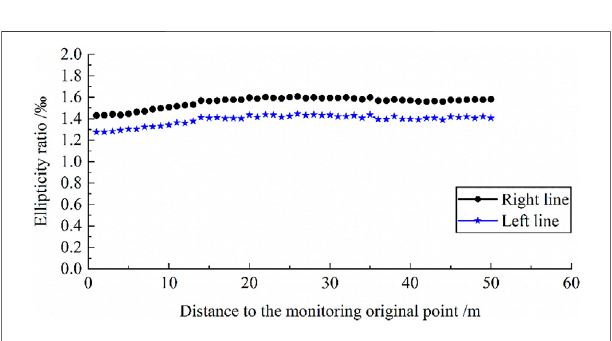
FIGURE 16| The ellipticity ratio ofthe tunnel in the longitudinal direction.